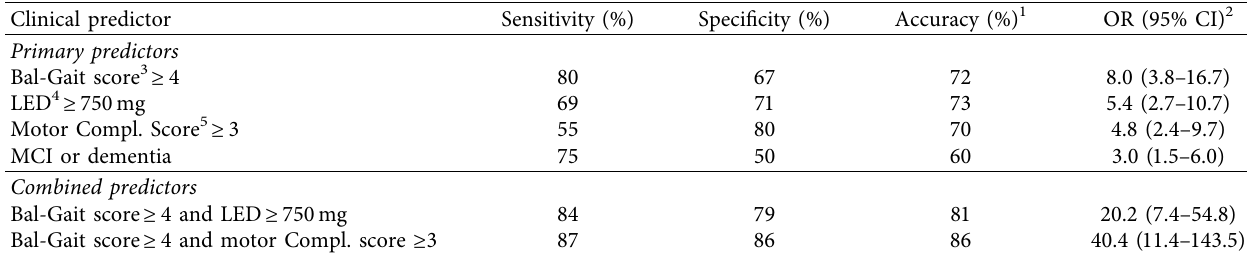
Table 6: Accuracy of clinical predictors of freezing of